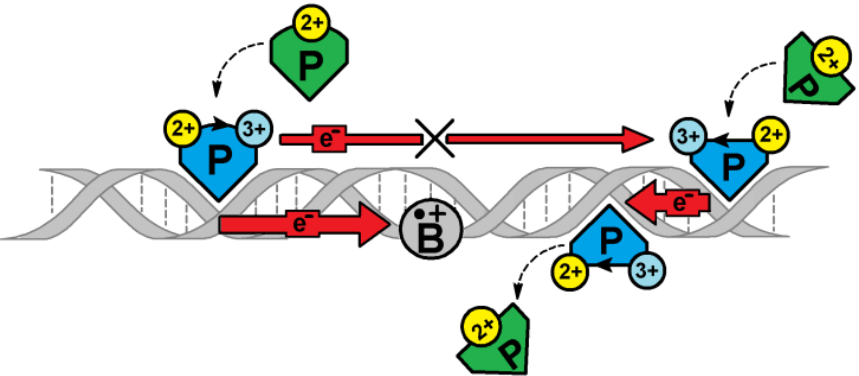
Figure 1. A schematic overview of [4Fe-4S] glycosylase (P - MutyH) DNA damage (B - oxo dG) recognition under ds -DNA charge transfer mode (red arrow). Glycosylase in its second oxidation state